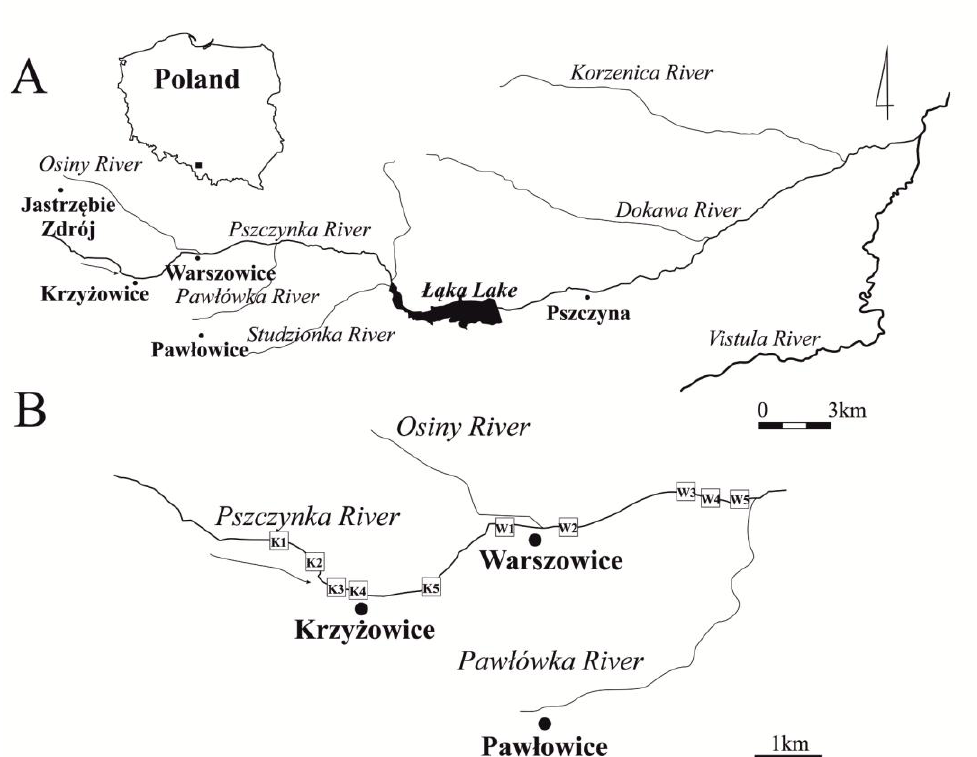
Fig. 1. Location of study area (A) and sampling sites along the Pszczynka River (B) in the area of Pawłowice community The main right-bank tributaries in this fragment are Pawłówka and Studzionka, while the left- bank are the channel Branicki and Osiny